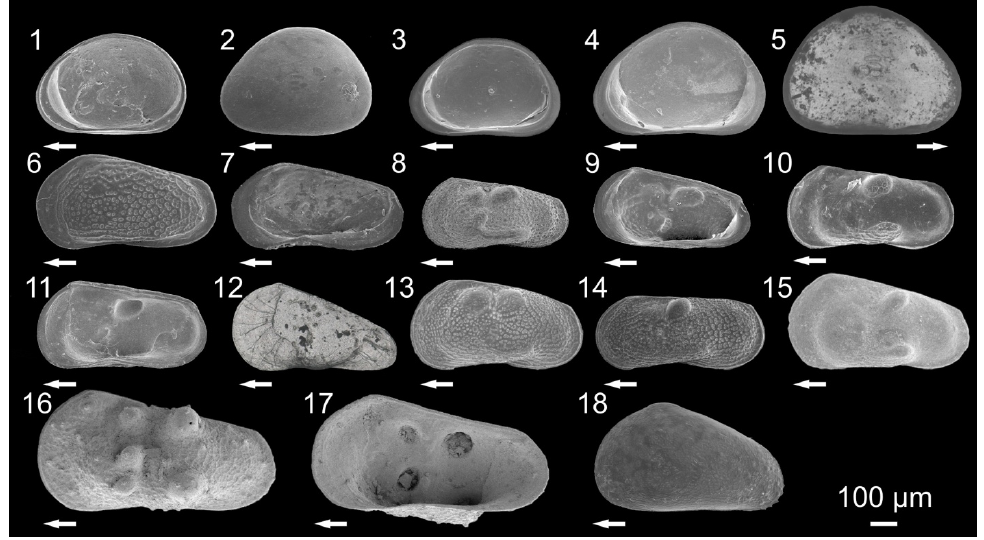
Figure 5. Pictures of ostracodes from Lake Ohrid: Cyclocypris ovum ( 1 ) Right valve (RV), internal view, female; Cypria obliqua ( 2 ) Left valve (LV), external view, female; C. obliqua ( 3 ) RV, internal view, female; C. lacustris ( 4 ) RV, internal view, female; Cypria ophtalmica ( 5 ) LV, internal view, isolated valve; Amnicythere karamani ( 6 ) LV, external view, female; A. karamani ( 7 ) RV, internal view, female; Paralimnocythere ochridense ( 8 ) LV, external view, male; P. ochridense ( 9 ) RV, internal view, female; Paralimnocythere karamani ( 10 ) LV, external view, female; P.karamani ( 11 ) RV, internal view, female; Paralimnocythere alata ( 12 ) LV, external view, female; Paralimnocythere slavei ( 13 ) LV, external view, female; P. slavei ( 14 ) LV, external view, male; Paralimnocythere georgevitschi ( 15 ) LV, external view, female; Paralimnocythere umbonata ( 16 ) LV, external view, female; P. umbonata ( 17 ) RV, internal view, female; Prionocypris zenkeri ( 16 ) LV, external view, juvenile. Arrows point to anterior part of valves (modified from [30]).